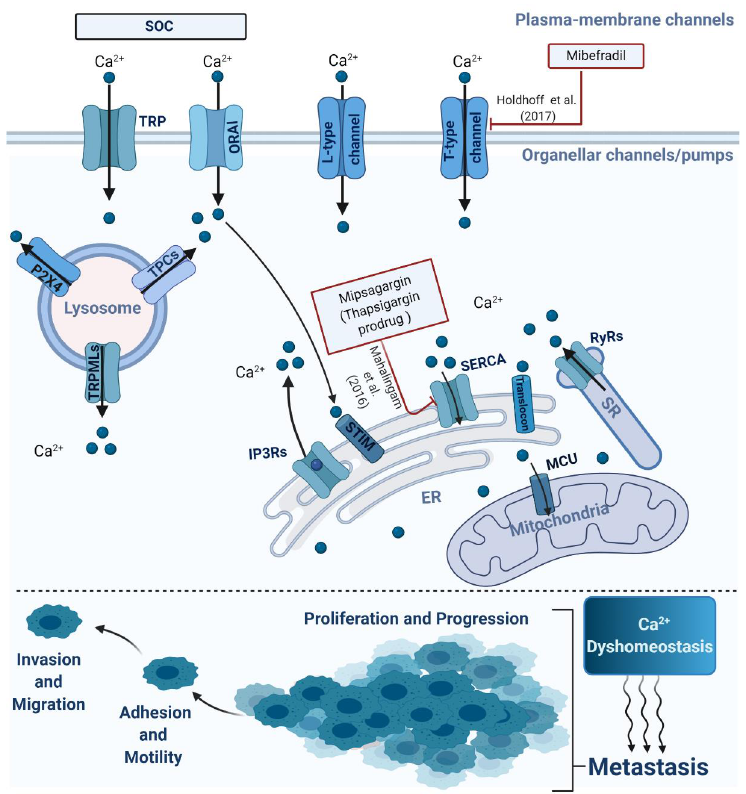
Figure 1. Schematic representation of the main intracellular or extracellular calcium channels involved in metastasis. The alterations of Ca 2+ homeostasis via organellar or plasma channels/pumps were implicated in several processes attributed to cancer metastasis, involving cell proliferation, invasion, migration and progression. 2. Intracellular Calcium Signalling in Metastasis 2.1. Endoplasmic and Sarcoplasmic Reticulum Ca 2+ Channels/Pumps